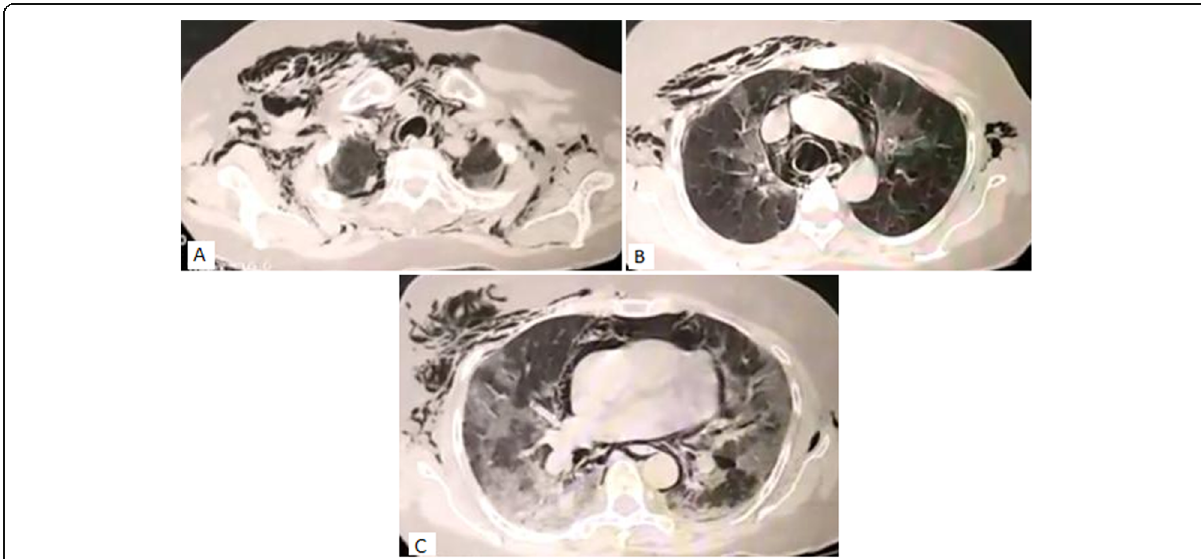
Fig. 2 Axial CT chest images showing. A Subcutaneous emphysema extending up to posterior chest wall. B Presence of air around the trachea and major blood vessels indicative of pneumoediastinum along with bilateral upper lobe ground glass opacities. C Presence of air dissecting the pericardium indicative of pneumopericardium with bilateral extensive lower lobe ground glass